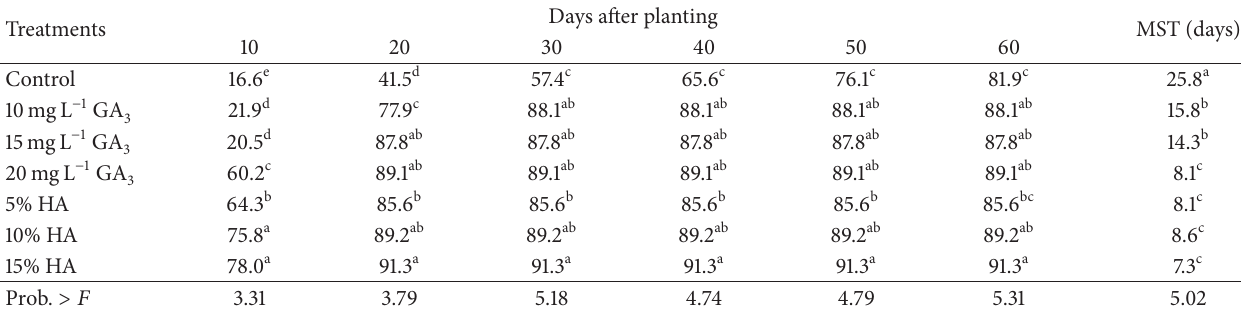
Table 1: Cumulative sprouting percentage (%) and mean sprouting time (days) of safed musli tubers as affected by different concentrations ) and humic acid (HA). of gibberellic acid (GA 3 Treatments